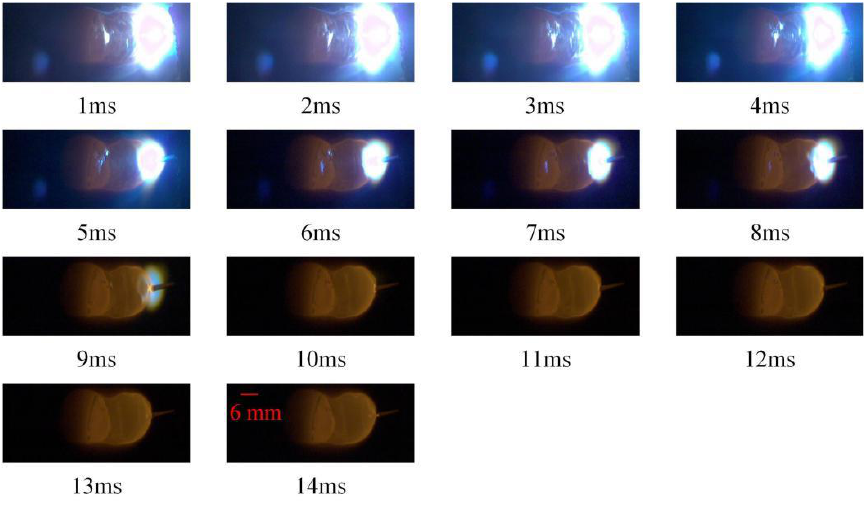
Figure 6. All images collected within CMT cycle.